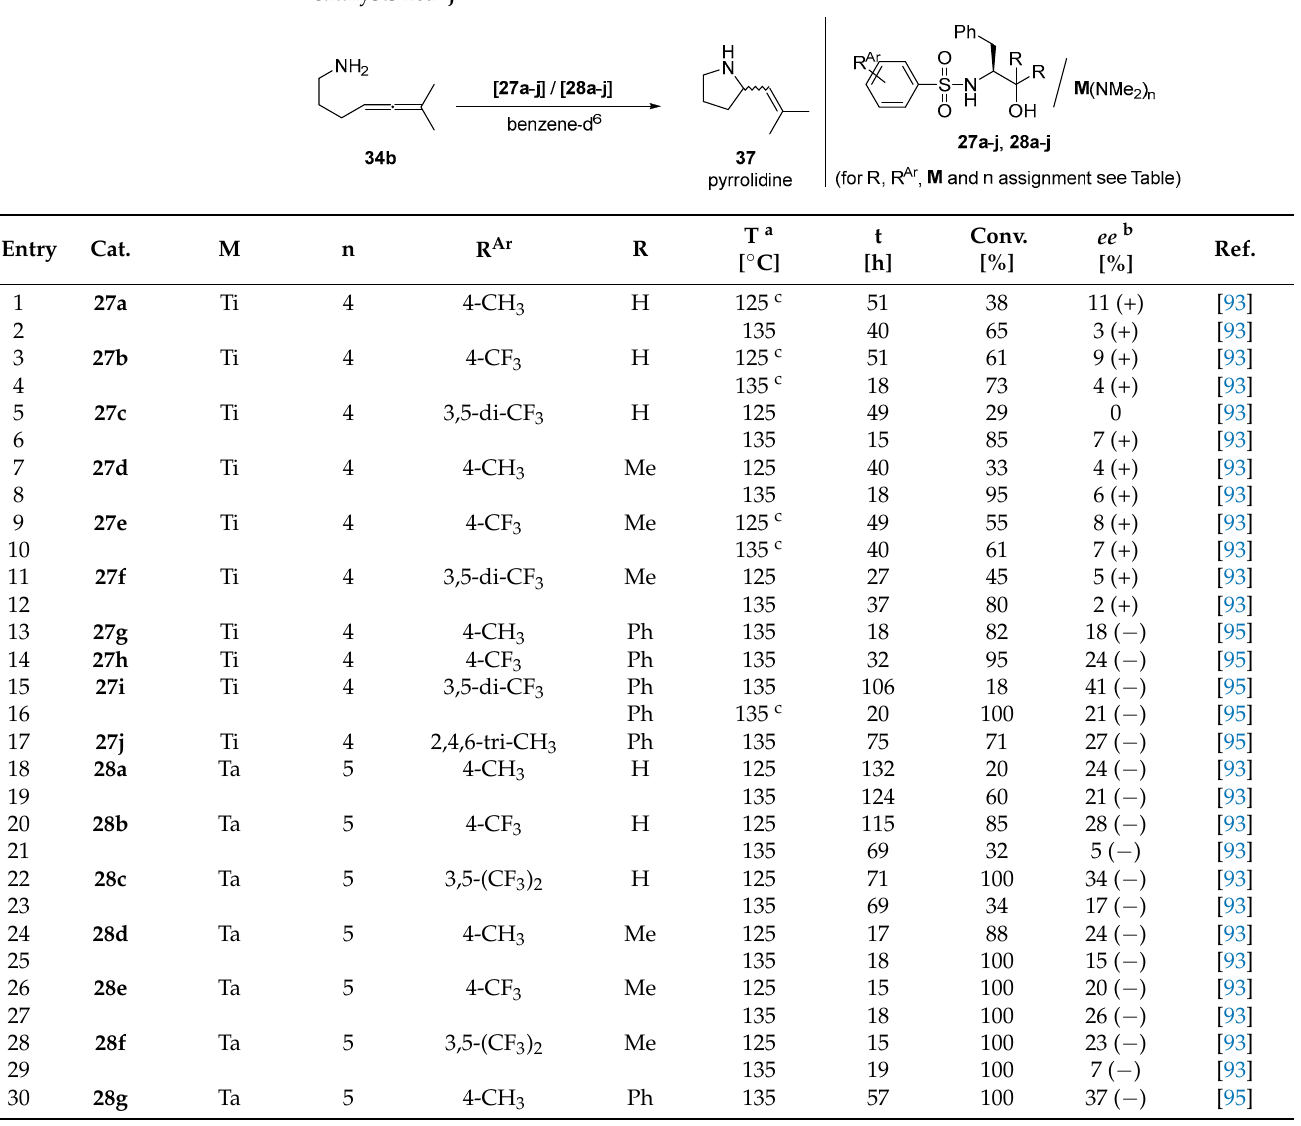
Table 7. Catalytic asymmetric hydroamination of 34b using chiral titanium 27a – j and tantalum catalysts 28a – j a .